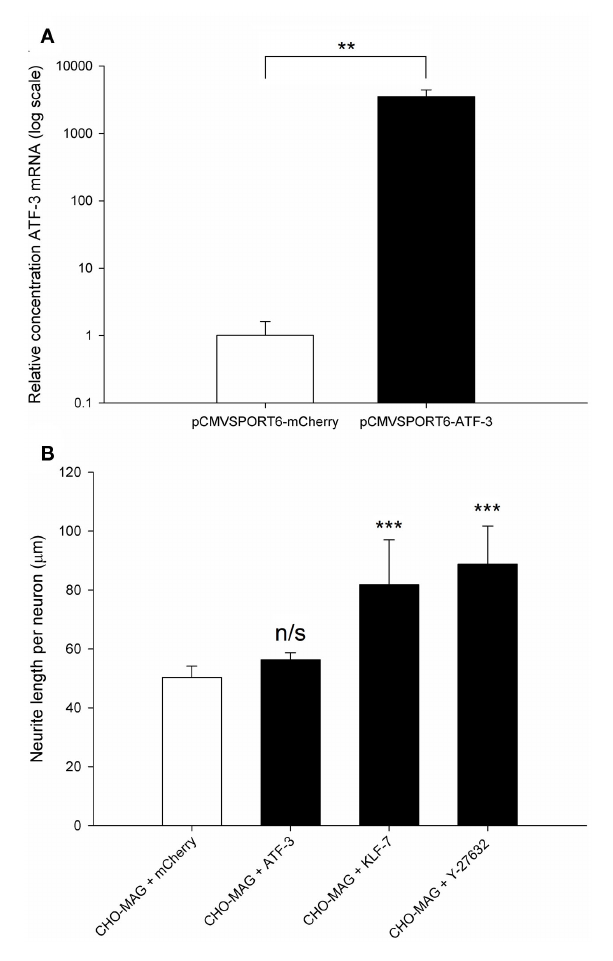
FIGURE 6 | Regeneration-associated genes are successfully over-expressed following electroporation, and over-expression of KLF-7 but notATF-3 was able to enhance neurite outgrowth on an inhibitory MAG substrate. (A) Quantification of the relative level of ATF-3 mRNA in electroporated CGNs. Significantly higher levels (2700-fold) of ATF-3 were detected in CGNs transfected with the ATF-3 plasmid compared to CGNs transfected with the mCherry plasmid.Values represent mean and SD; analysis was performed using an independent samples Student’s t -test ( ∗∗ P < 0.01), n = 4. (B) Quantification of the mean neurite length per transfected neuron of CGNs cultured on CHO-MAG cells.The CHO-MAG inhibition could be partially reversed by over-expressing KLF-7 or addition of 20 μ MY-27632 but not by over-expressing ATF-3.Values represent mean and SD; analysis was performed using one way ANOVA with Dunnett’s post hoc tests comparing to CHO-MAG cells ( ∗∗∗ P < 0.001), n =